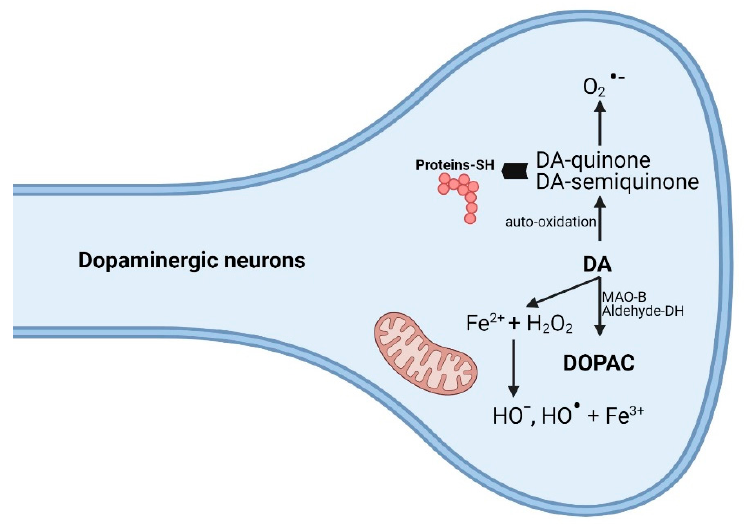
Figure 6. Toxic reactions of dopamine (DA) metabolites generated after oxidation. The neurotoxicity of DA is due to reactive oxygen species (ROS) produced as a result of monoamine oxidase (MAO) metabolism or as a result of an auto-oxidation process. 1. Under the action of MAO, 3,4- dihydroxyphenylacetic acid (DOPAC), and H 2 O 2 are later transformed into ROS (OH − , OH • ). within mitochondria. 2. The process of self-oxidation results in DA-quinones and DA-semiquinones which in turn generate ROS (O 2 •− ). These metabolites also interact with the–SH groups of proteins with toxic cellular action by altering the structure and/or function of protein. Created with BioRender.com (accessed on 22 January